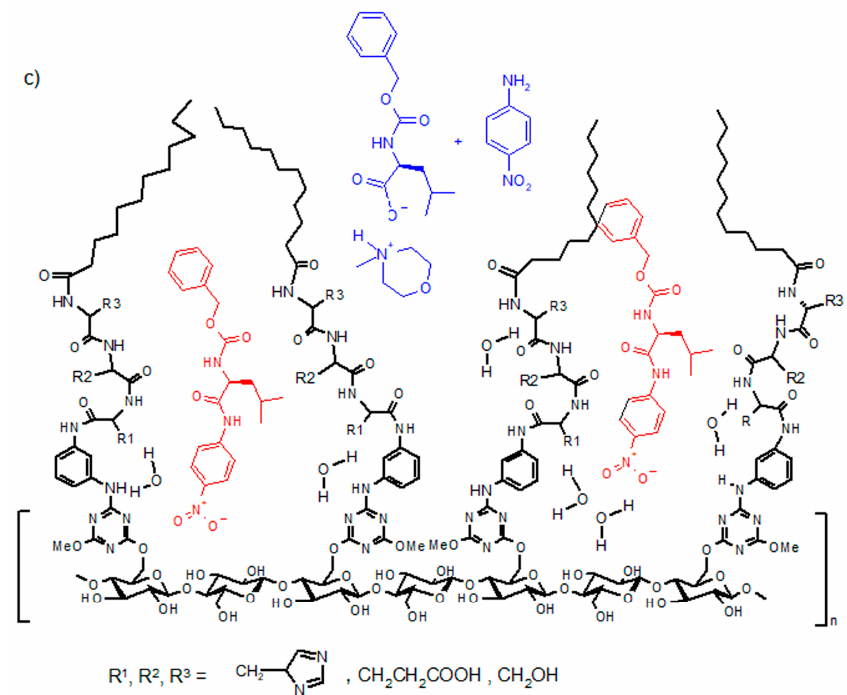
Figure 11. The proposed mechanism of action of synzymes able to split amide bond. ( a ) binding the substrate in the catalytic pocket; ( b ) closure of the substrate in the catalytic cavity and simultaneous formation of new binding sites; ( c ) release of reaction products and simultaneous closure of substrates in adjacent catalytic cavities.